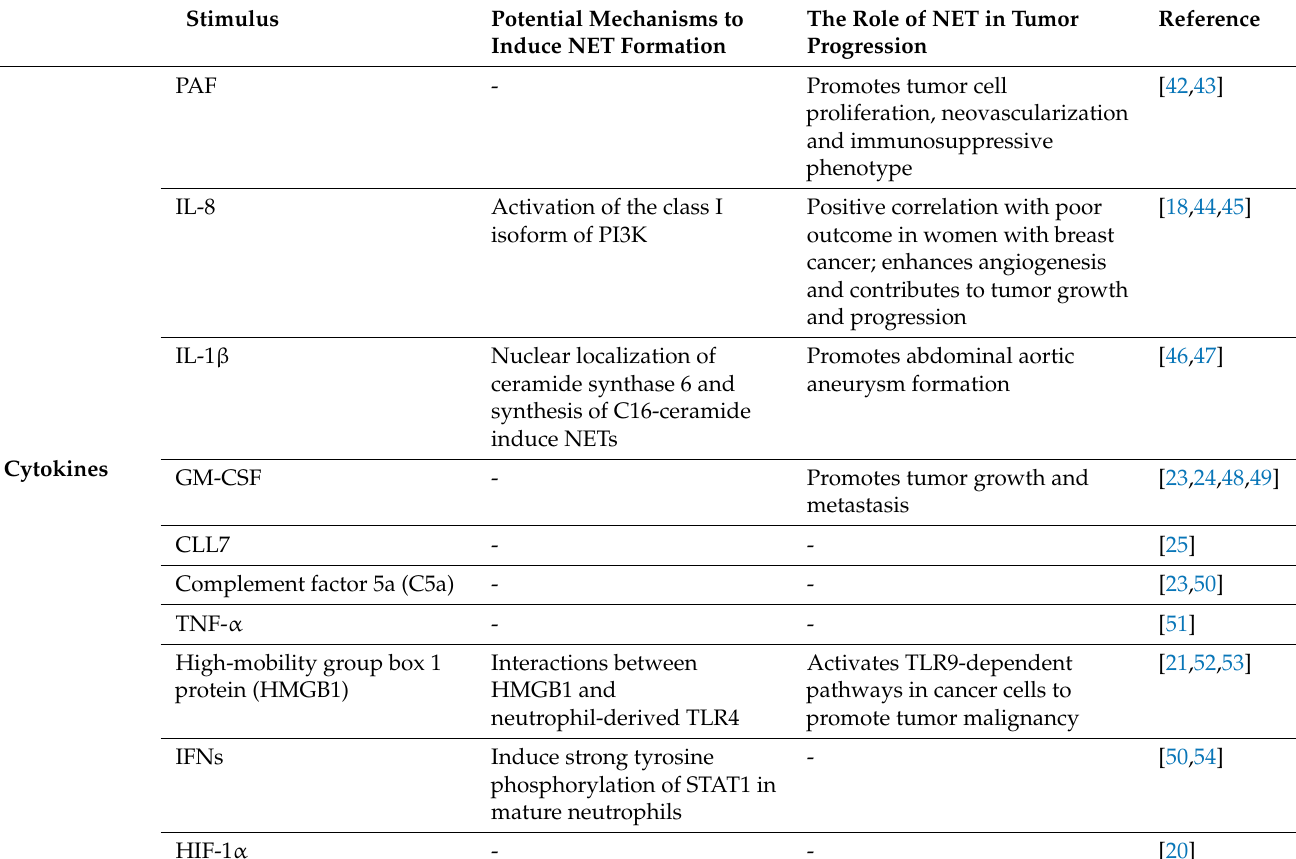
Table 1. List of stimulants known to induce NET formation and the relation to tumor metastasis.